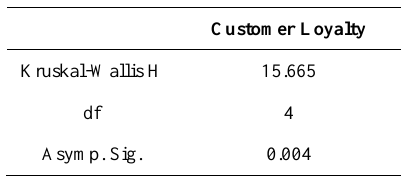
Table 17. Kruskal Wallis test – Test statistics a,